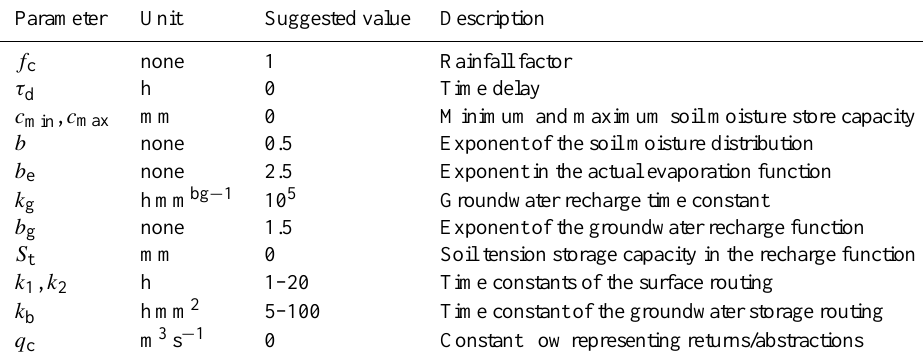
Table 2. Parameters in the PDM model (Moore, 2007).